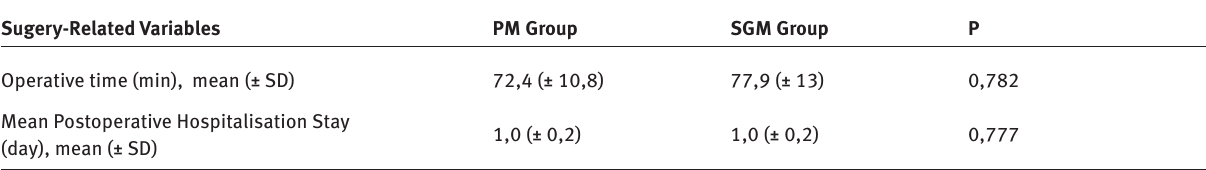
Table 2b: Surgery-Related Variables in elderly